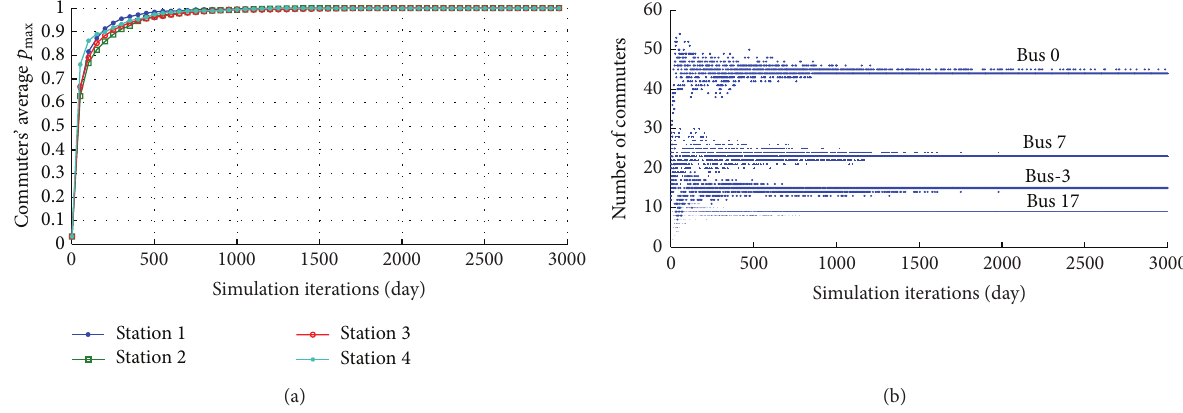
Figure 10: Commuters’ average 𝑝 max and number of commuters on typical buses.